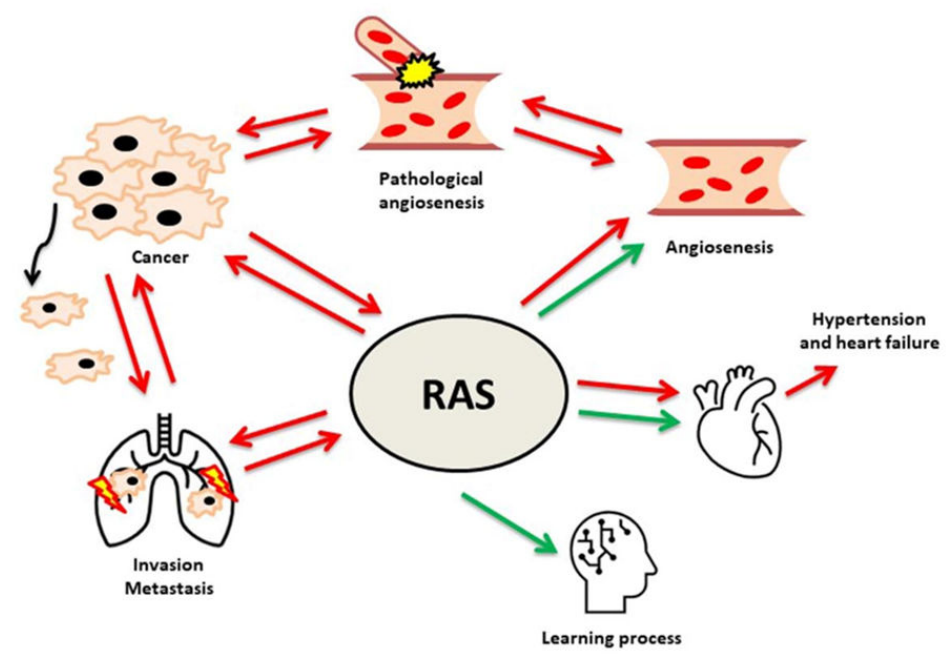
Figure 1. The various effects of the renin-angiotensin-system